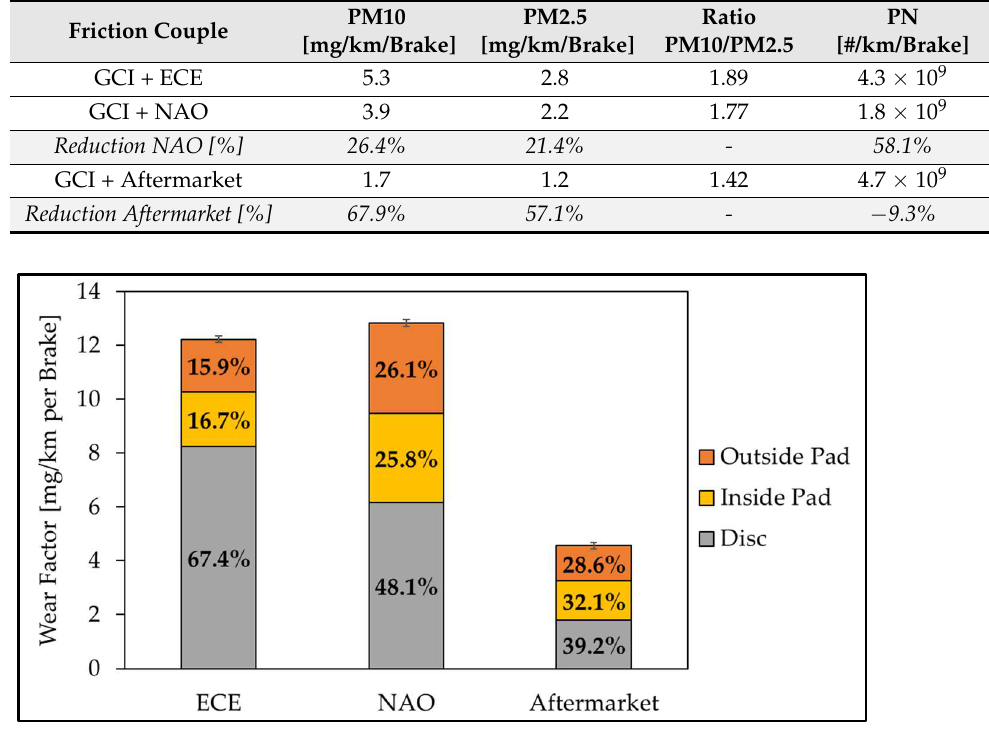
Figure 5. Wear factors of the three different brake pad compositions after 8x WLTP Brake Cycle.